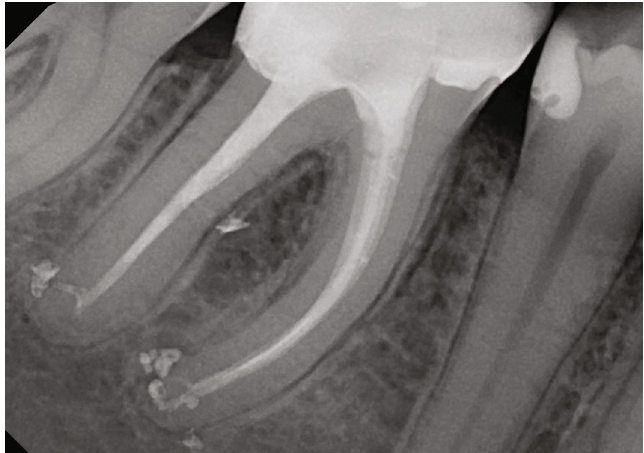
Figure 4: Two-year follow-up visit. Full healing was observed in the furcation and the periapical areas of tooth #